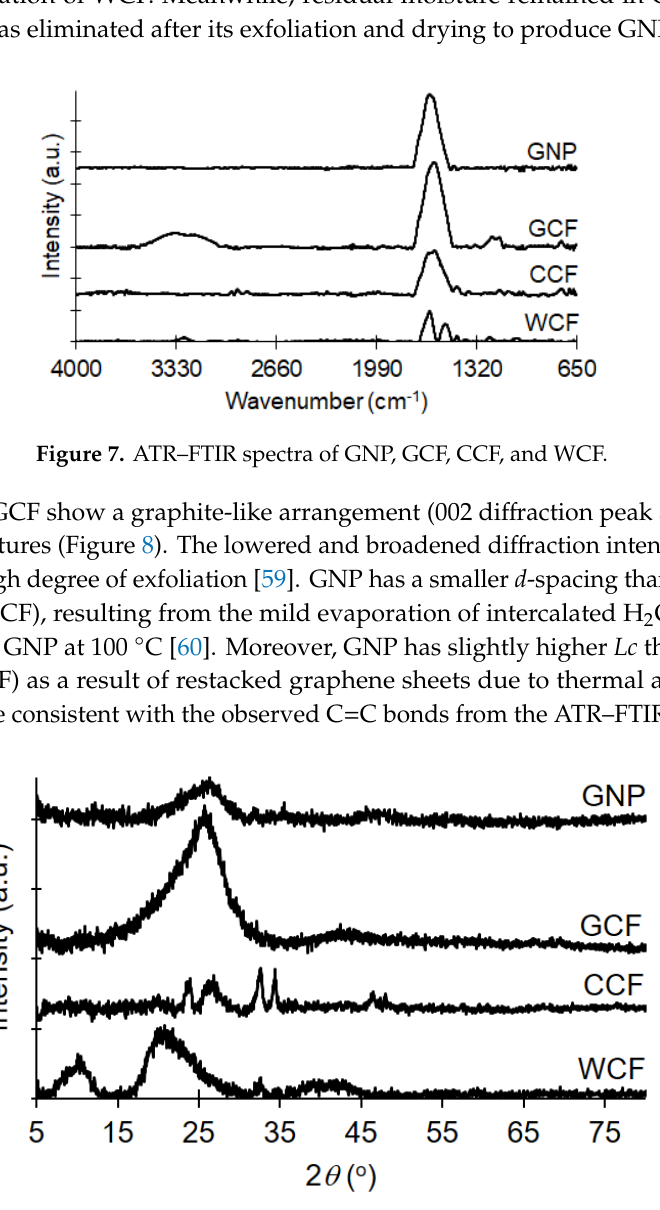
Figure 8. XRD patterns of GNP, GCF, CCF, and WCF.